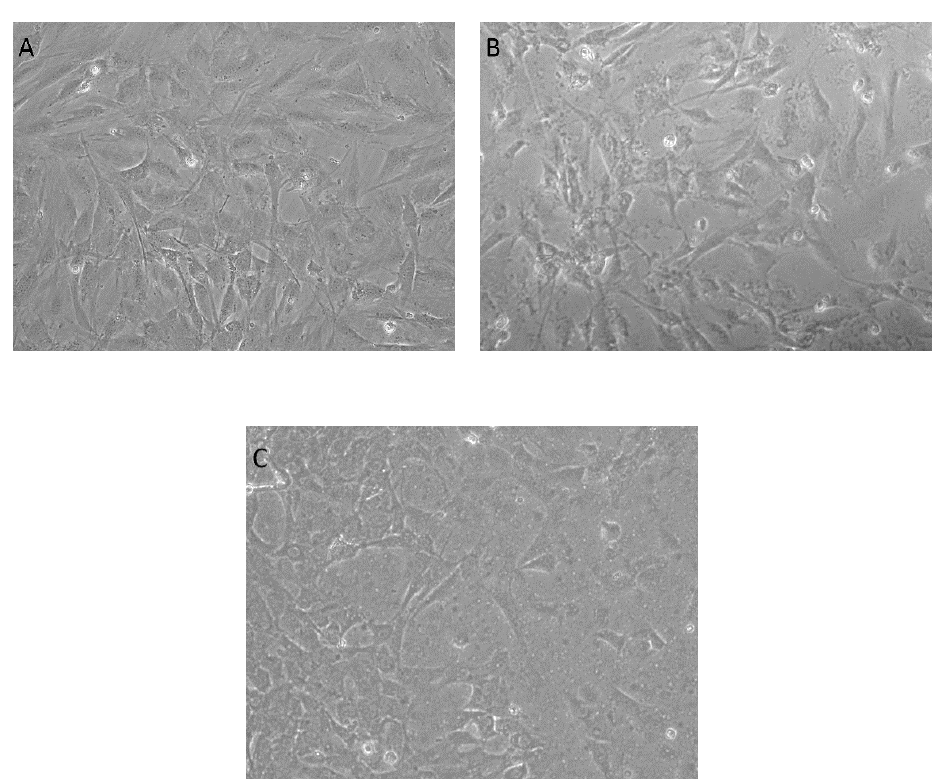
Figure 9. Cell viability and NO level after 24 h-incubation of MC3T3-E1 osteoblasts with Fe 3 O 4 @CS and Fe 3 O 4 @CS/LyZ samples. The results were calculated as mean values ( n = 3) and expressed relative to control samples (uncoated substrate).